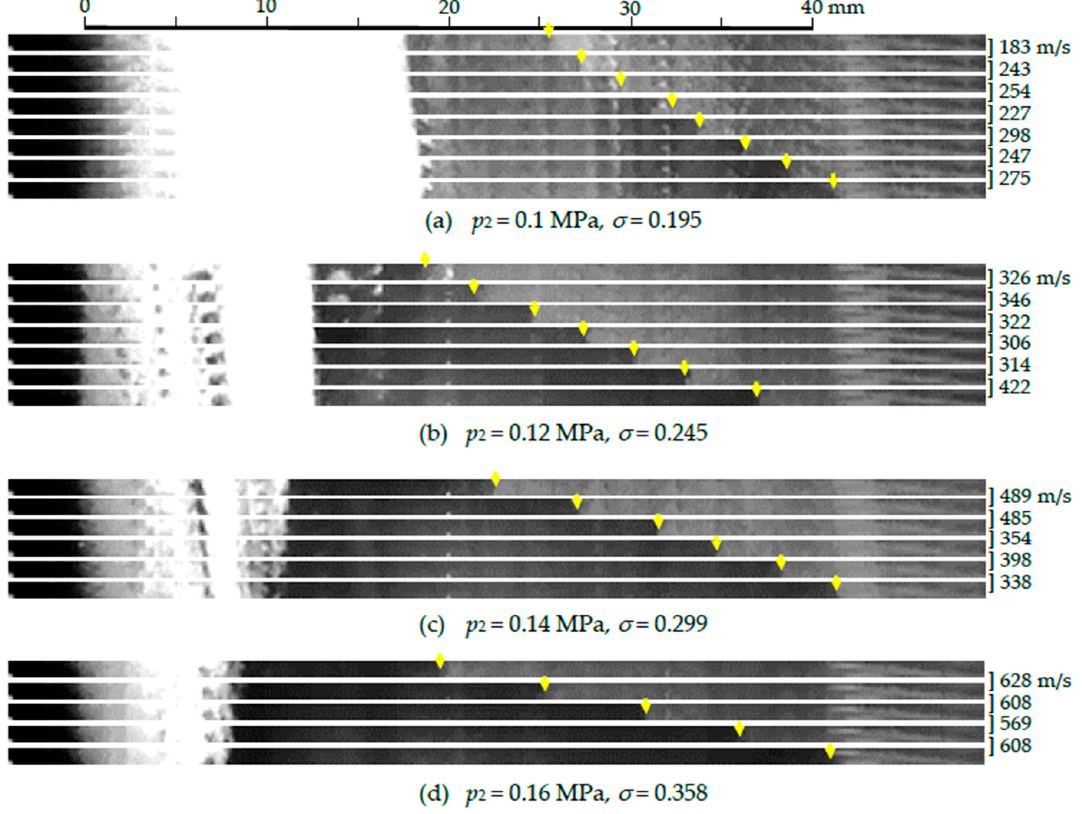
Figure 18. Aspects of pressure wave in Venturi tube changing with cavitation number. The recording speed of the camera was 109,999 fps. Appl. Sci. 2020 , 10 , x FOR PEER REVIEW